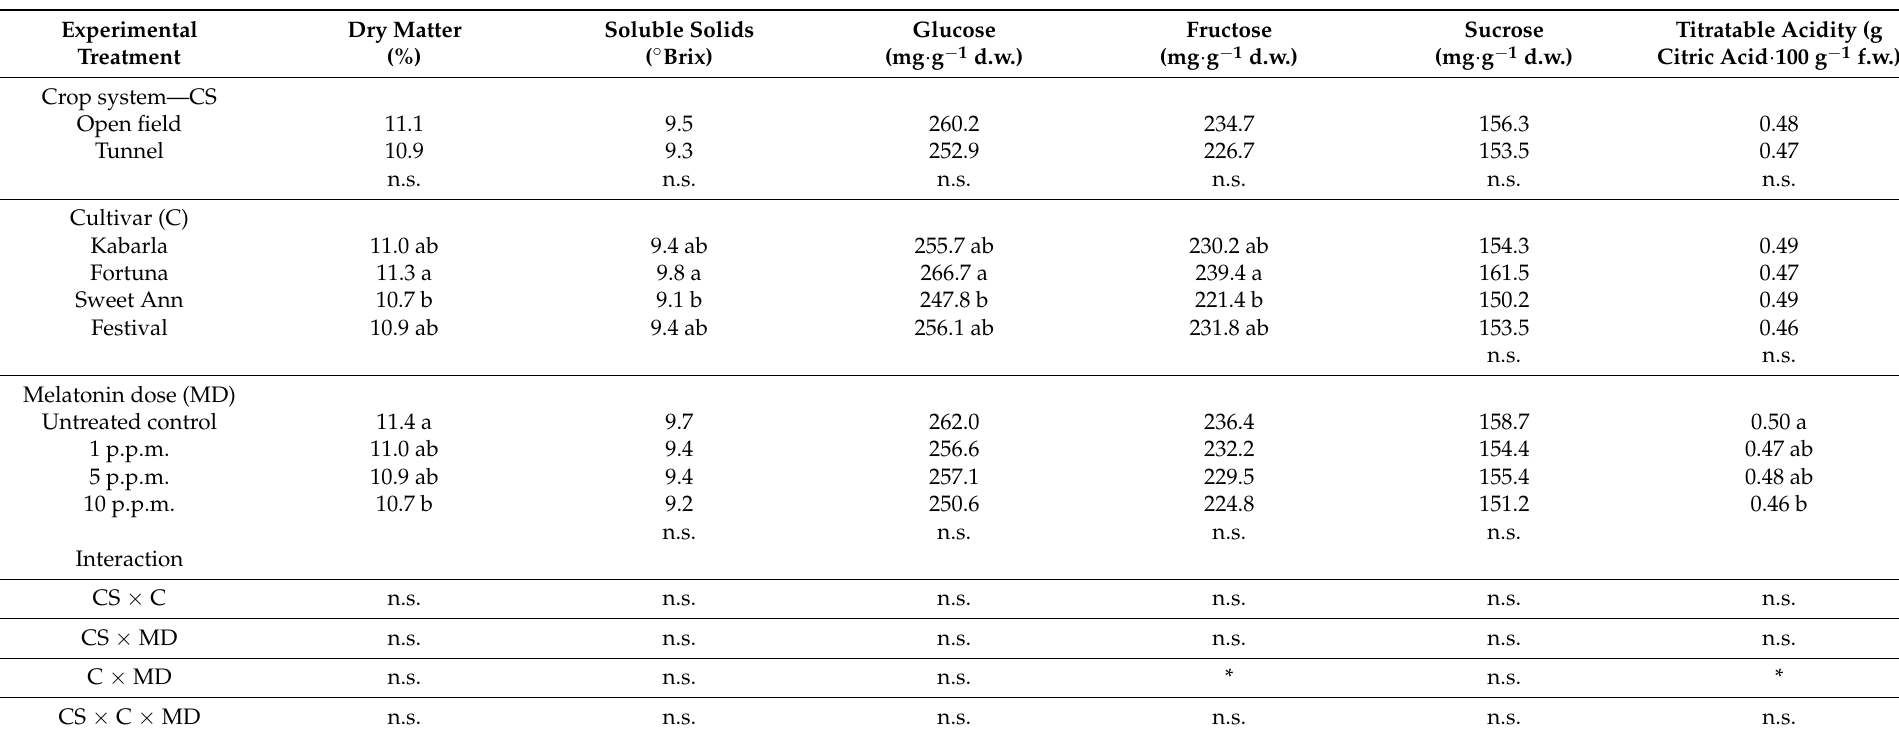
Table 2. Effects of crop system, cultivar and melatonin dose on quality attributes of strawberry fruits grown in Turkey.